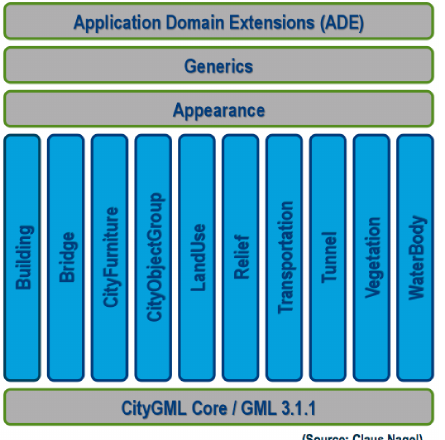
Figure 1. CityGML 2.0 with 10 supported Thematic Modules